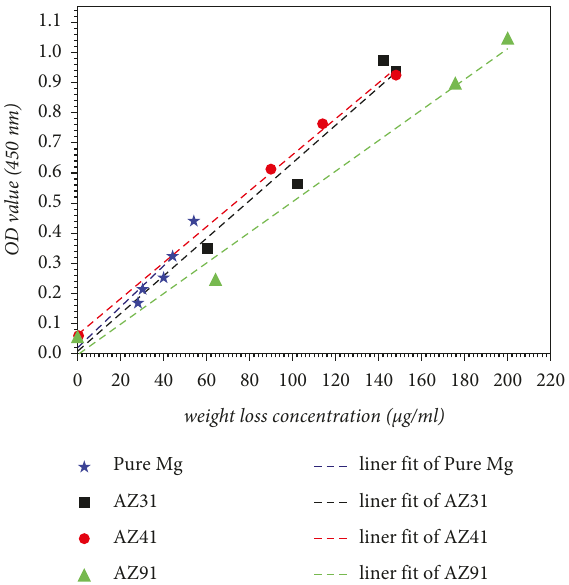
Figure 7: The results of the feasibility analysis of OD value and concentration of magnesium ions dissolved in the HBSS solution. The concentration of magnesium ion was taken as the X value, and the OD value of the solution monitored at the time point was plotted as the Y